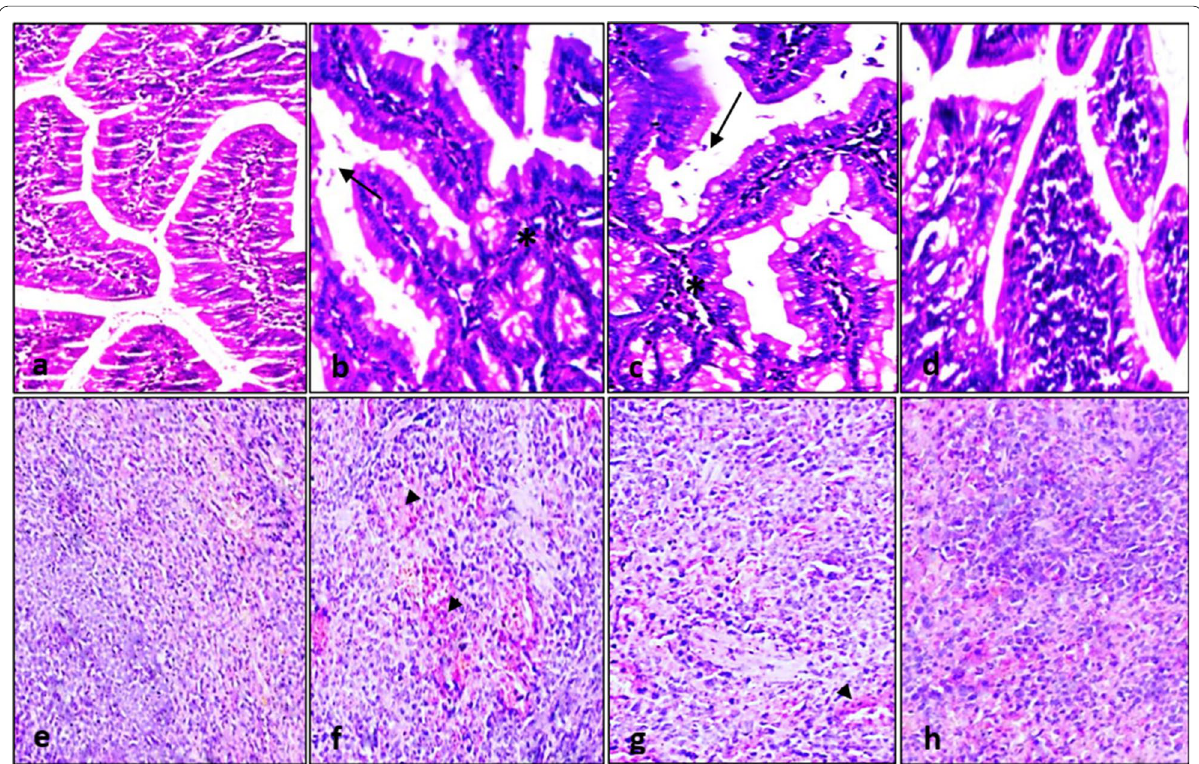
Fig. 1 Haematoxylin and eosin intestinal sections showing preserved villous architecture and intact brush borders in healthy control group I ( a , 200) and G. duodenalis infected protected group IV (1/200 µg/ml pAb, d , × trophozoites (arrows) in G. duodenalis infected unprotected group II ( b , c , 200). Haematoxylin and eosin spleen sections showing average lymphoid follicles and average blood sinusoids in healthy control group I × ( e , 200) and G. duodenalis infected protected group IV (1/200 µg/ml pAb, h , × sinusoids (arrow heads) in G. duodenalis infected unprotected group II ( f , g , ×